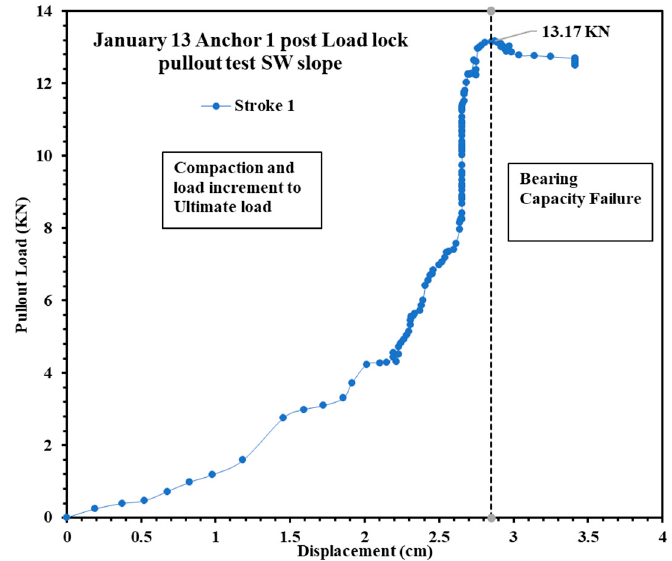
Figure 16. Anchor 1 post-load-lock pull-out test on the southwest slope.